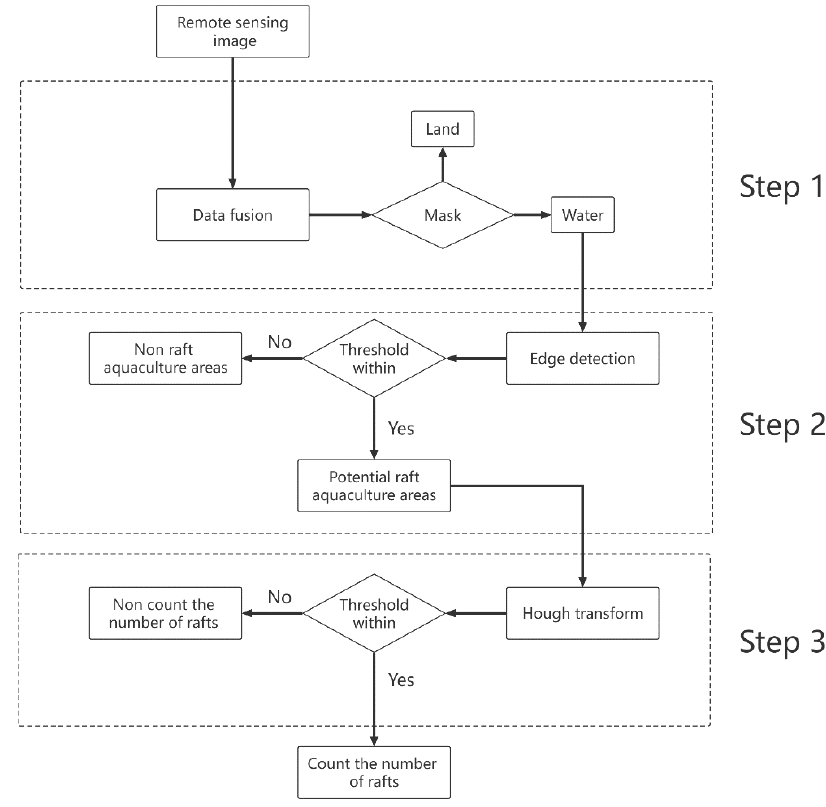
Figure 2. Workflow of the study.